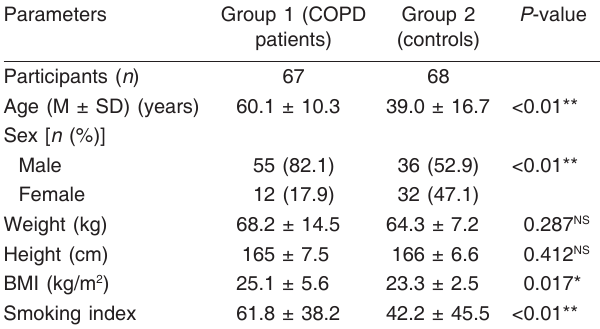
Table 1 Demographic data among the studied groups